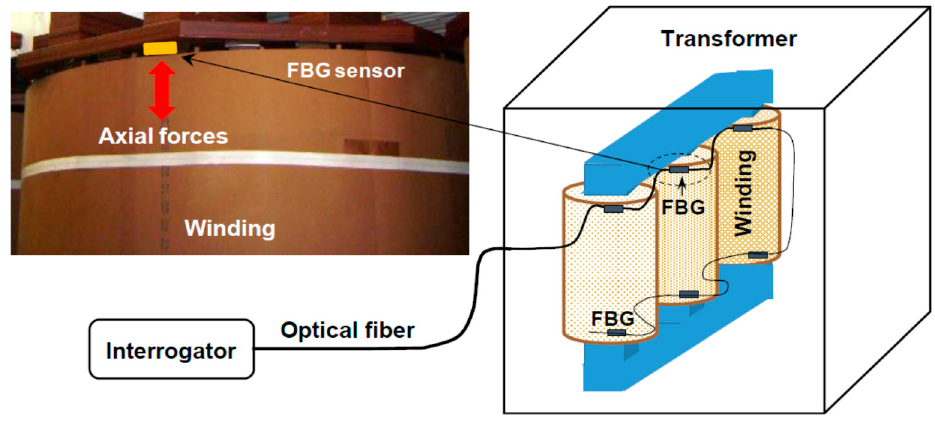
Figure 6. Fiber Bragg grating (FBG) sensor deformations in transformer windings [46].